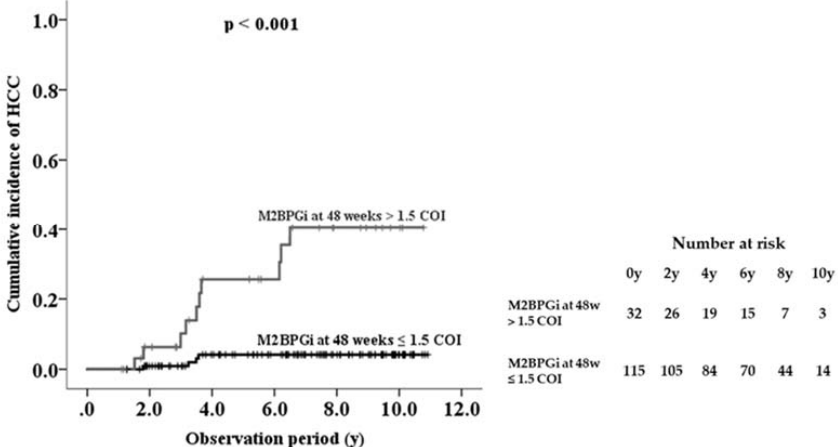
Figure 4. Cumulative incidence of hepatocellular carcinoma (HCC) development in patients with chronic hepatitis B during nucleot(s)ide analogue therapy, shown according to serum Mac ‐ 2 ‐ binding protein glycosylation isomer (M2BPGi) level at 48 weeks.